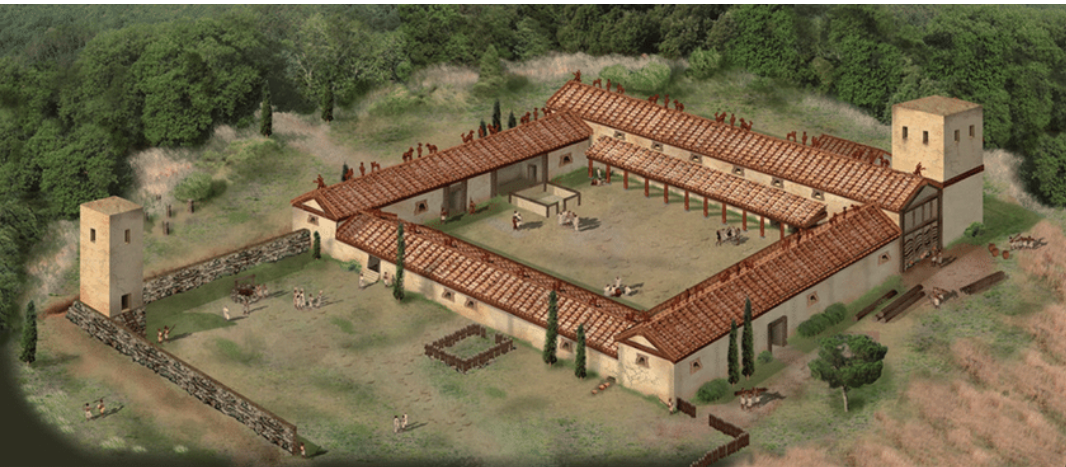
Figure 10. Reconstruction of the Archaic Complex, 600–535 BCE, depicting the possible arrangement of acroteria, as proposed by Evan Baston (Image: Poggio Civitate Project).